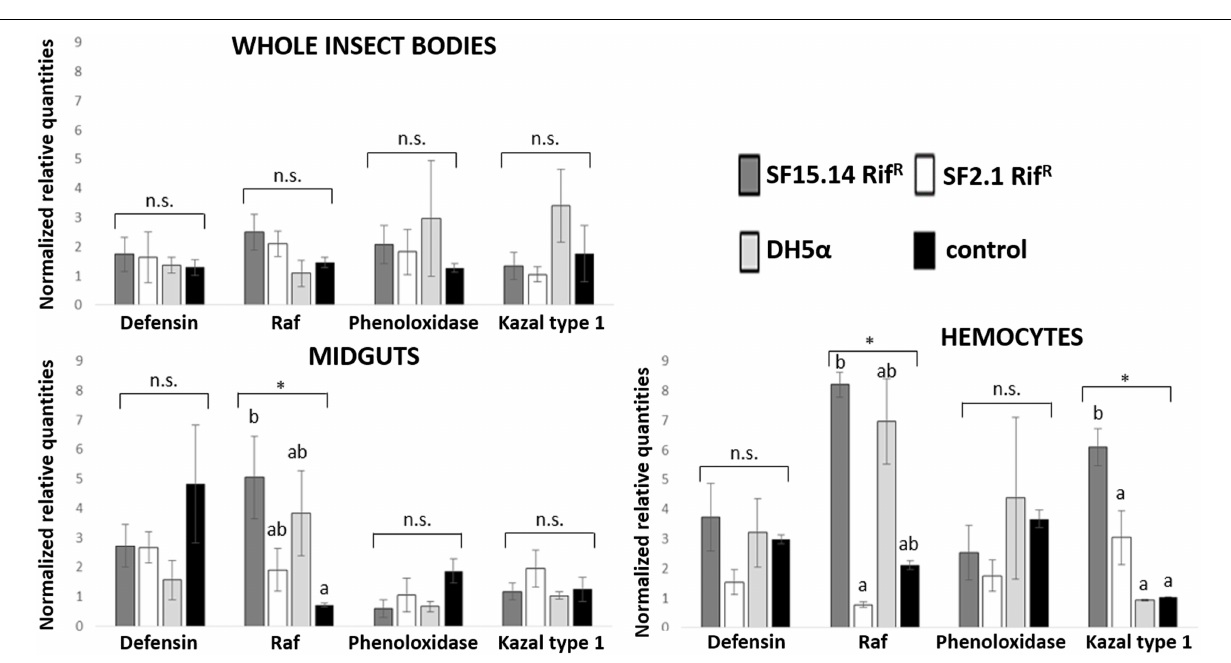
Frontiers in Physiology |